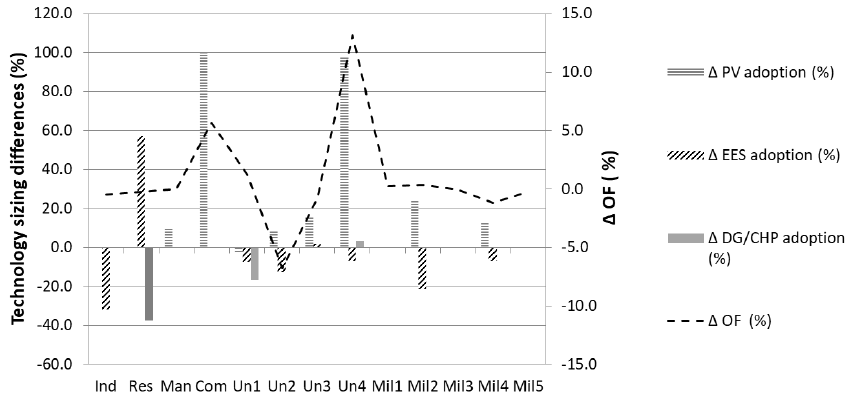
Figure 8. OF differences (bars) and run-time savings (line) for the RO approach compared to the FSO. Negative run-time numbers represent savings.